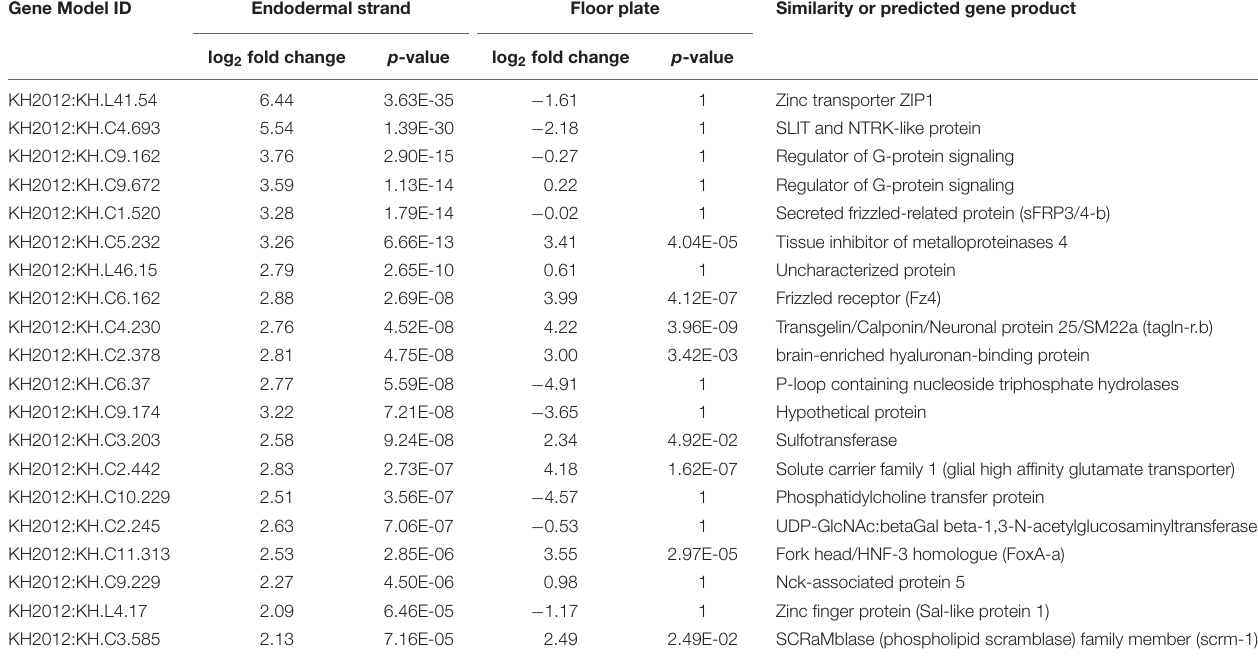
TABLE 1 | Top 20 upregulated genes in the endodermal strand at the mid tailbud stage. Gene Model ID Endodermal strand Floor plate Similarity or predicted gene